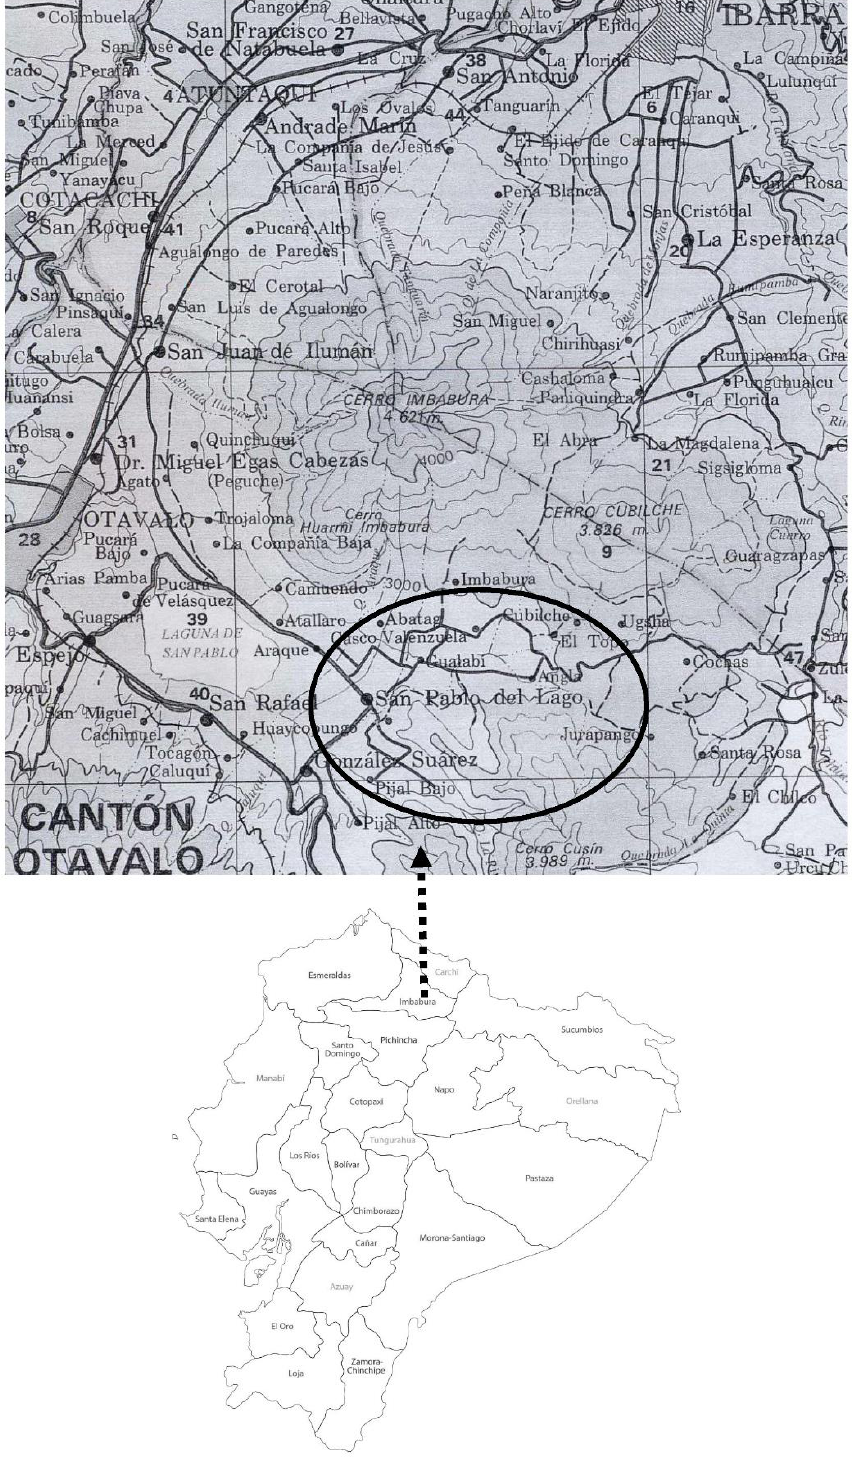
Figure 1. Map: Media Lengua communities in Imbabura province, Ecuador.